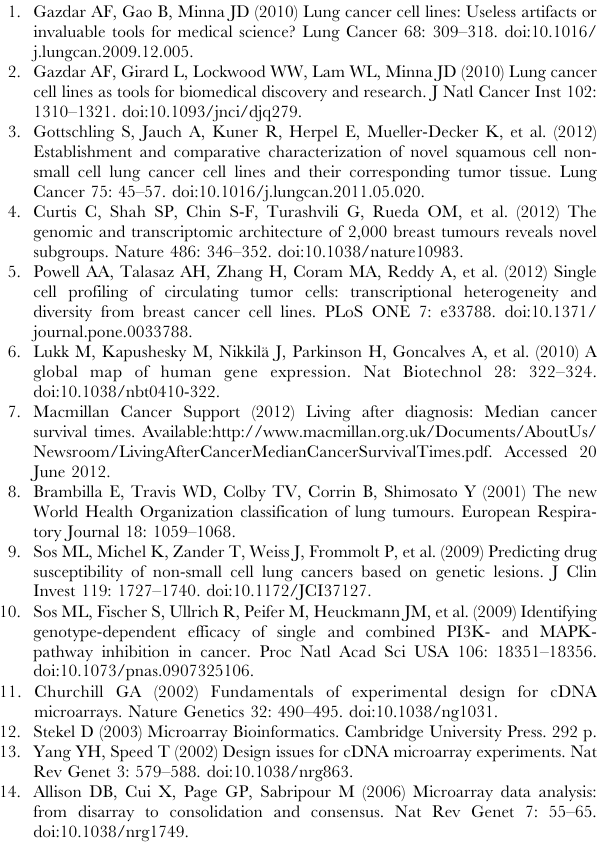
(TIFF) Figure S42 Heatmap for the differentially expressed genes between clusters 2 and 3 after Normalisation with RMA and Golub filtering for 300 probes. (TIFF) Figure S43 Heatmap for the differentially expressed genes between clusters 2 and 3 after Normalisation with RMA and Golub filtering for 1000 probes. (TIFF) Table S1 This contains the annotations that were added to the normalised data in Bioconductor including the clusters. (TXT) Table S2 This contains the full list of differentially expressed genes between all of the